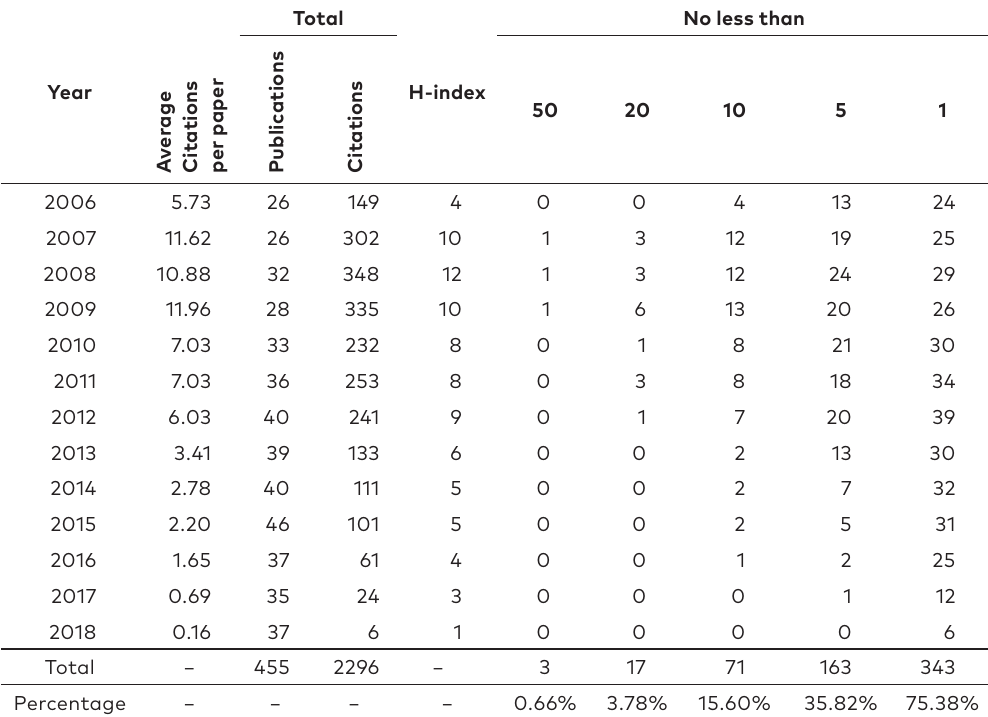
Table 3. Annual citation structure of the publications in